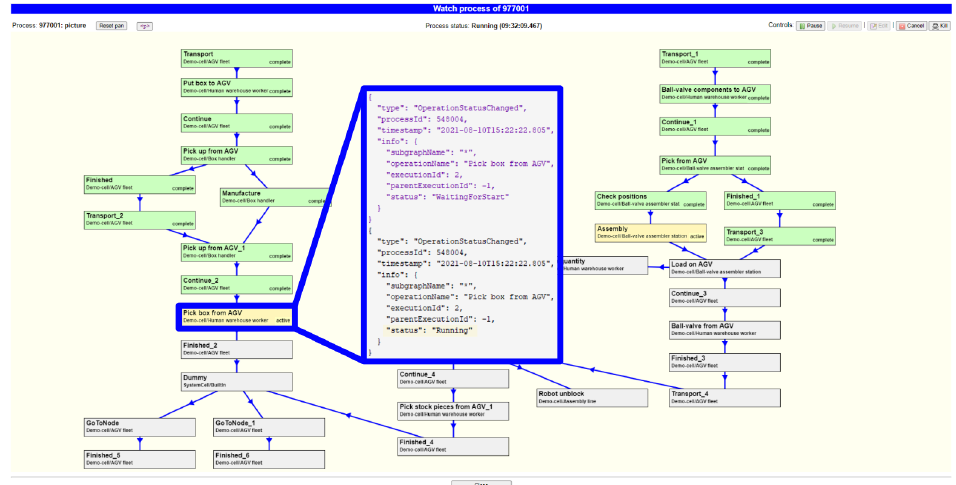
Figure 12. Process execution example with